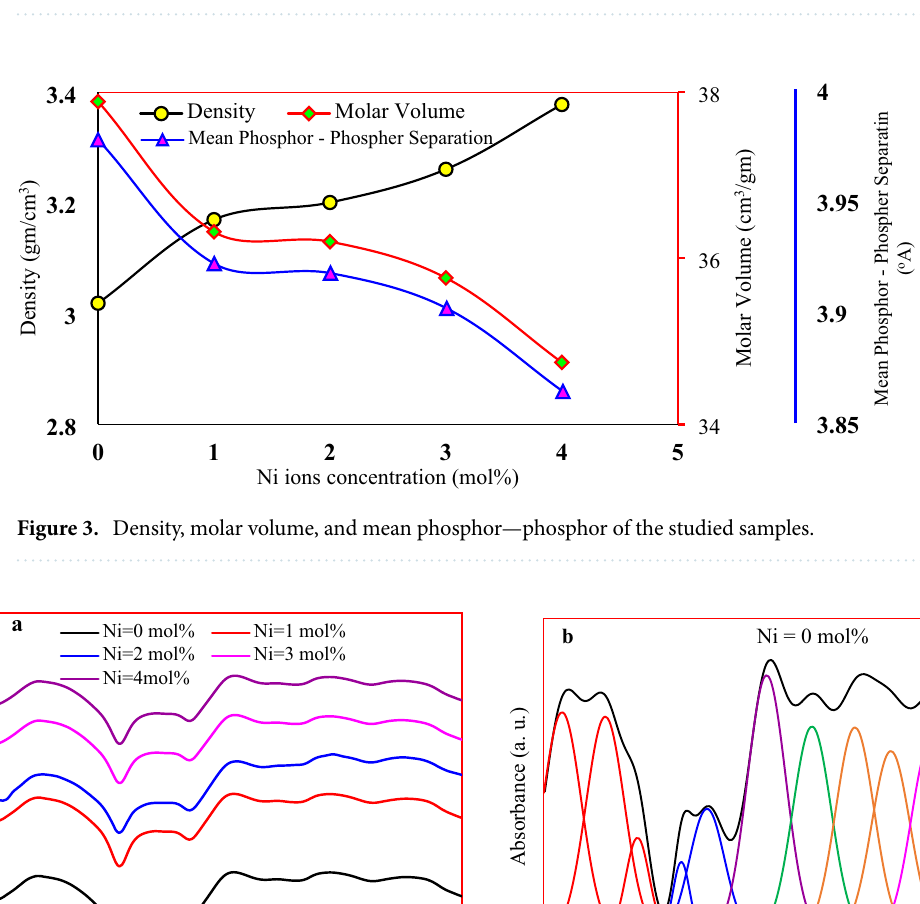
Figure 2. XRD diffraction pattern of the studied materials.